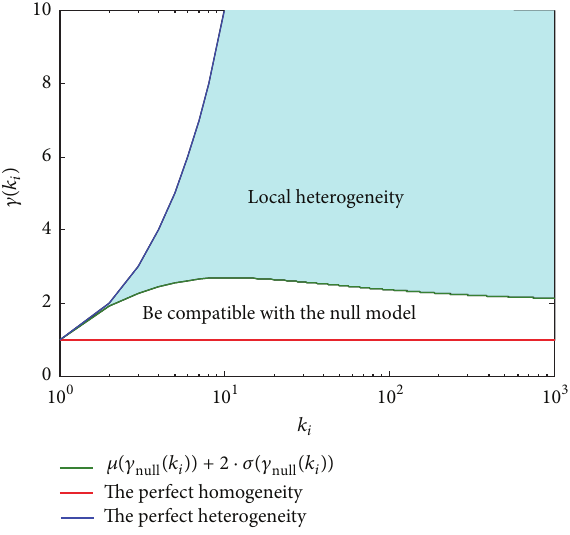
Figure 1: 𝛾(𝑘 𝑖 ) compared against the null model